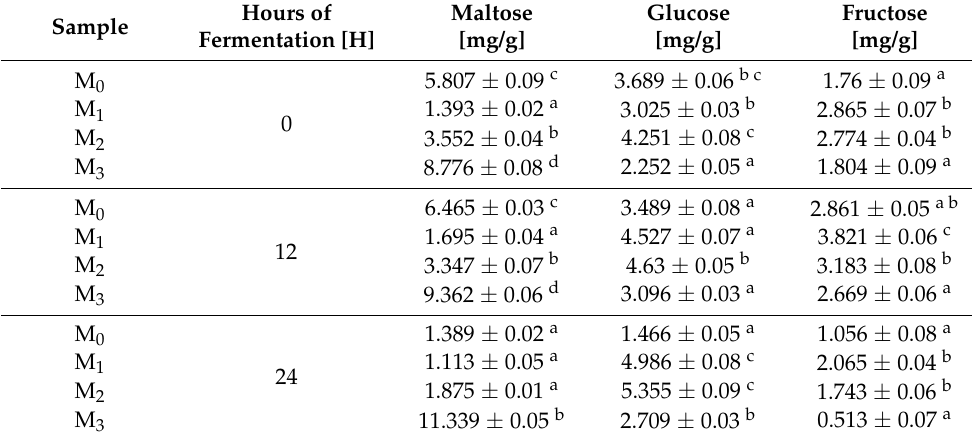
Table 2. Carbohydrates content (maltose, glucose, fructose) in sourdoughs with wheat flour (M 0 ), einkorn flour (M 1 ), spelt flour (M 2 ), and emmer flour (M 3 ), fermented for 0, 12, and 24 h with Lactiplantibacillus plantarum ATCC